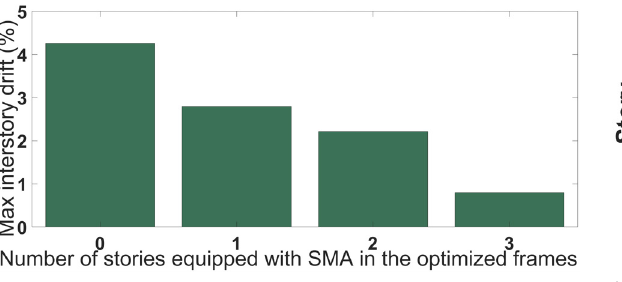
Figure 7: Maximum interstory drift of three-story frames regarding the number of stories equipped with SMA braces.